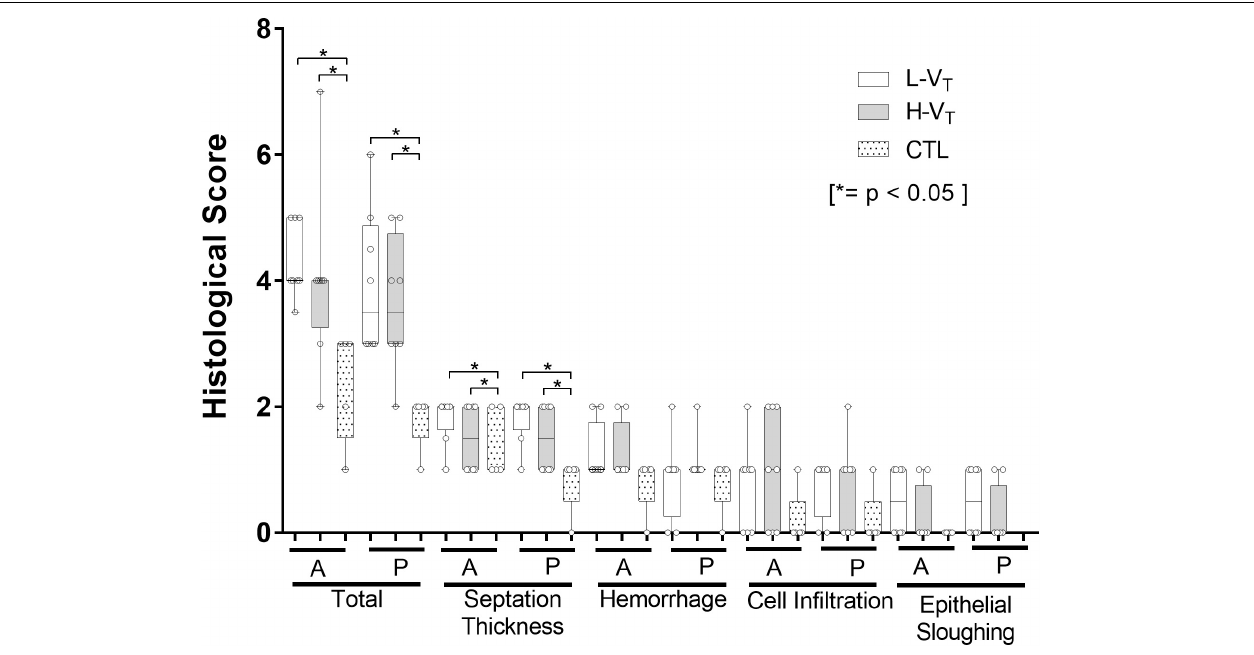
FIGURE 2 | Inflammation histological score in lambs subjected to TLV with L-V T ( n = 8), H-V T ( n = 8), and CTL ( n = 5). The total score out of eight represents the sum of the four categories scored over two (septation thickness, hemorrhage, cell infiltration, and epithelial sloughing). A: anterior region of the lung; P: posterior lung region. A higher score indicates more inflammation. Each point represents a lamb and each line represents the median and the first and third quartiles (Q1; Q3). *: statistically significant difference ( p <